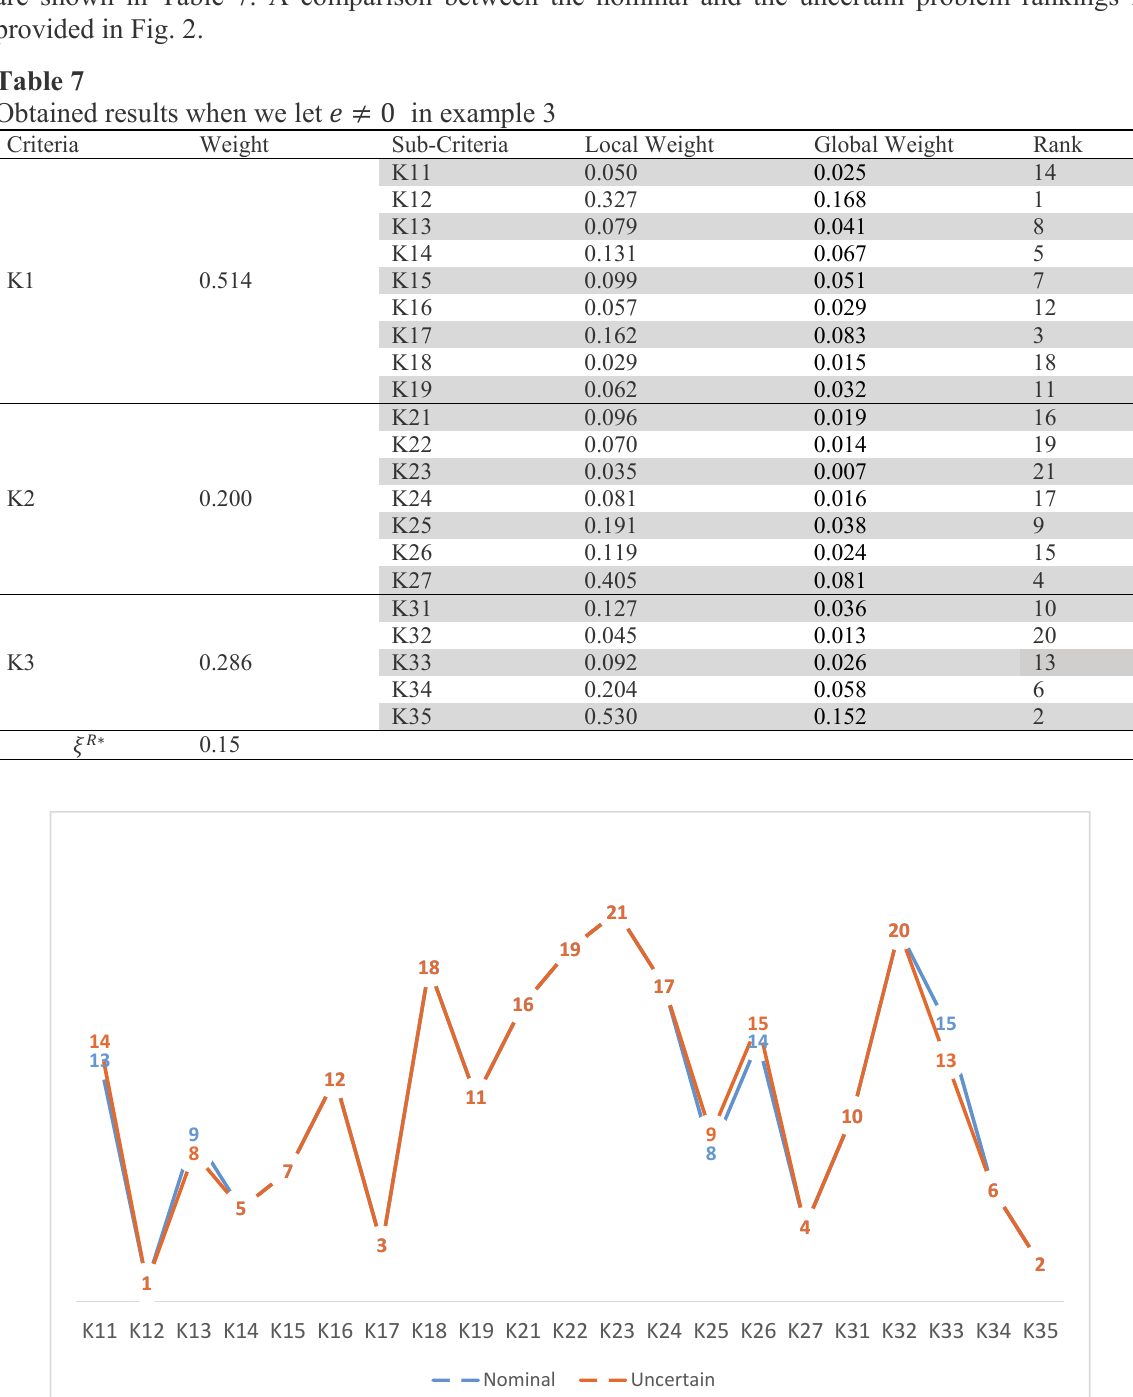
Fig. 2 . A compare between the rankings in the nominal and the uncertain